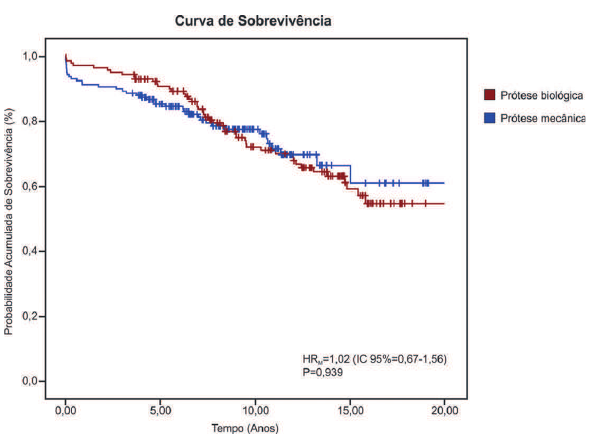
ICC=insuficiência cardíaca congestiva; DPOC=doença pulmonar obstrutiva crônica; AVC=acidente vascular cerebral; HAS=hipertensão arterial sistêmica; UTI=Unidade de Tratamento